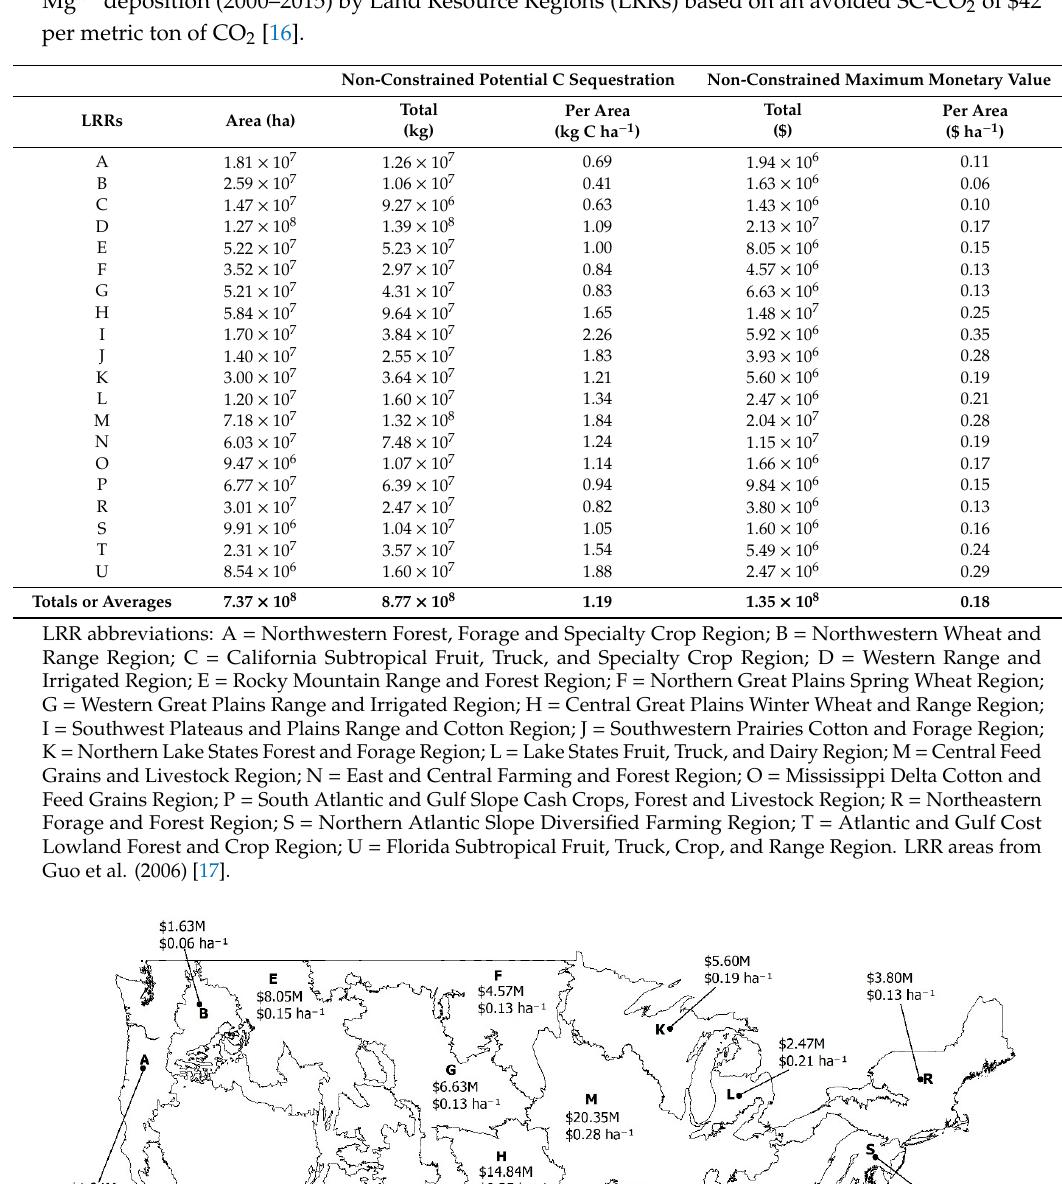
Table 5. Average annual total and area-normalized non-constrained potential soil inorganic carbon (SIC) sequestration within the contiguous United States (U.S.) from combined atmospheric Ca 2 + and Mg 2 + deposition (2000–2015) by Land Resource Regions (LRRs) based on an avoided SC-CO 2 of $42 per metric ton of CO 2 [16].